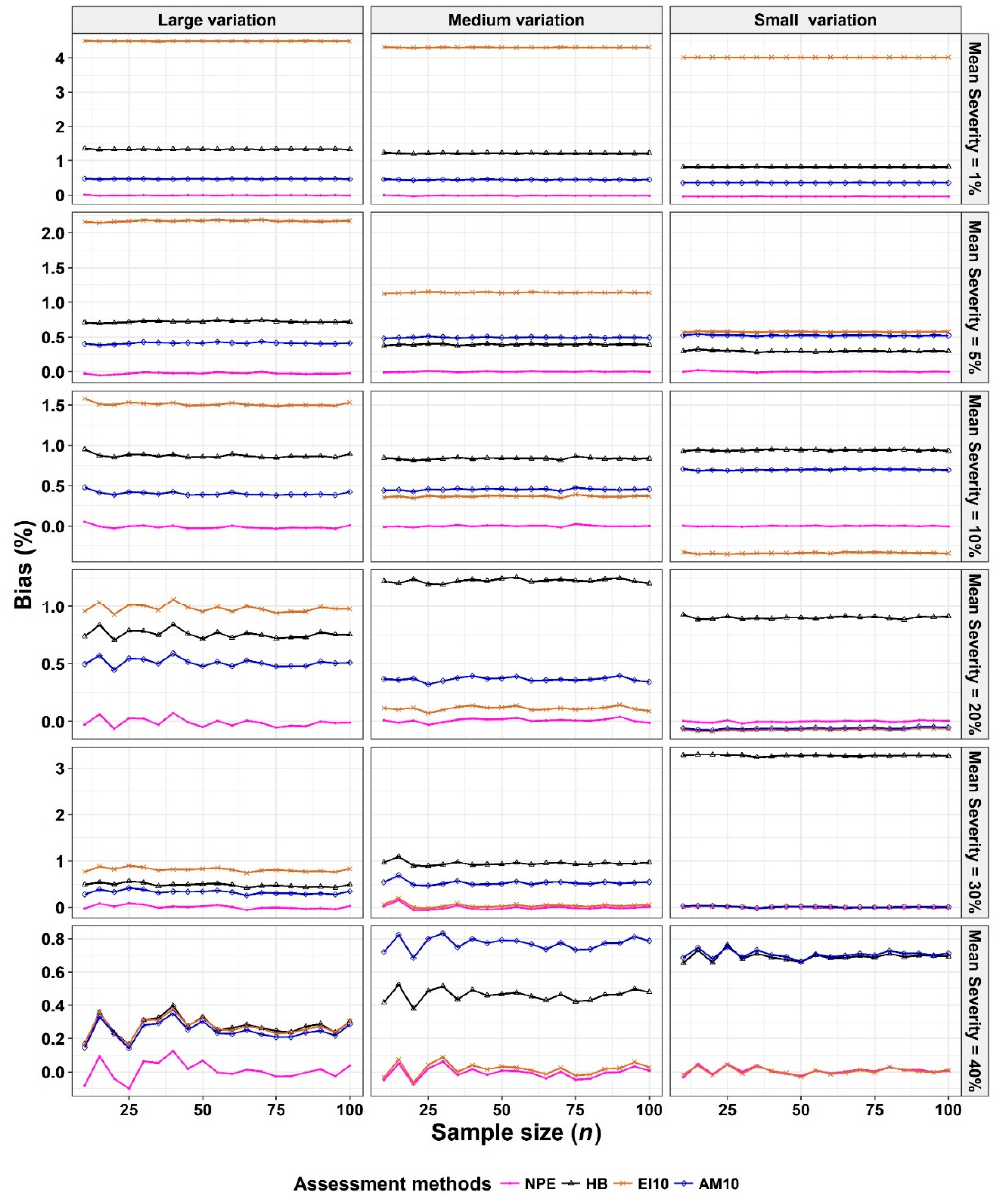
Figure 4. The relationships between the bias of mean disease severity estimates and sample size ( n ) (from n = 10 to 100 in n = 5 increments) for each of the different scales used, over a range of “actual” mean disease severities (1%, 5%, 10%, 20%, 30%, and 40%) and variance (represented by large, medium, and small variation). The simulation process was repeated 10,000 times. Assessment methods: (i) NPE (nearest percentage estimate); (ii) HB (Horsfall-Barratt scale); (iii) AM10 (10% linear scale emphasizing severities ≤ 50% disease, and with additional intervals at severities < 10%); (iv) EI10 (10% linear scale).